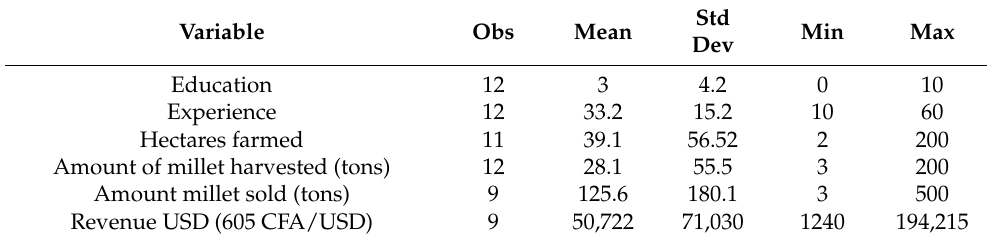
Table 2. Farmer Descriptive